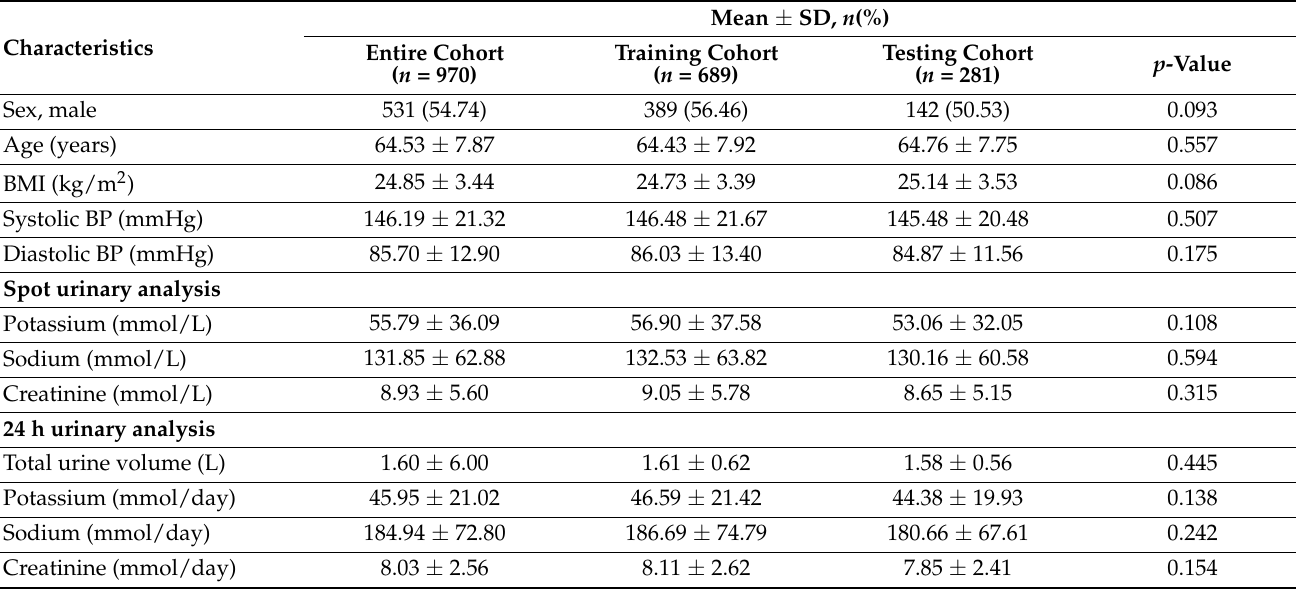
Table 1. Demographic data and clinical characteristics of the study population.